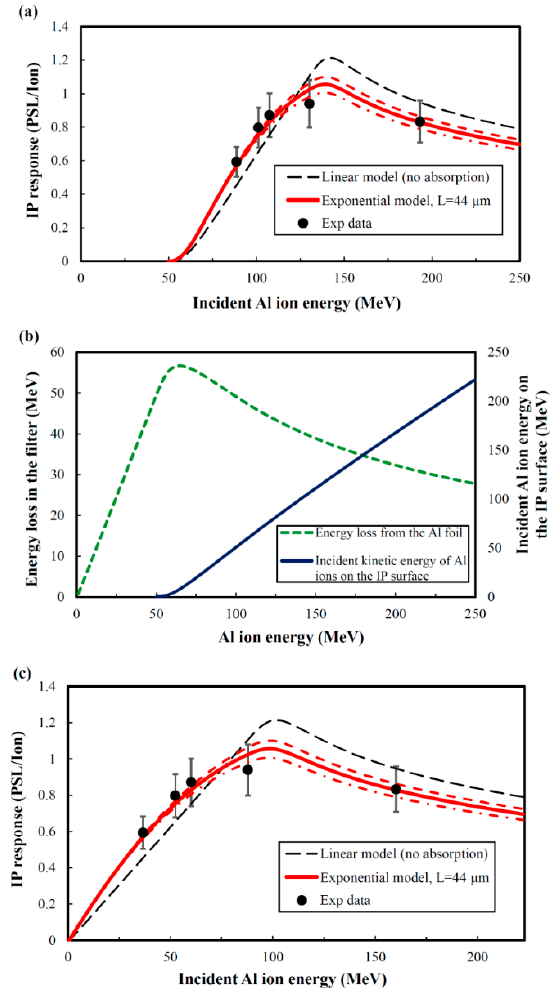
Figure 4. ( a ) IP response of BAS-TR IP is shown as a function of incoming Al ion energy before the filter. ( b ) Energy loss in the filter is shown as a function of Al ion energy (dashed green line). The incident kinetic energy of Al ions on the phosphor layer after penetrating through the filter is also shown as a function of Al ion energy (solid blue line). ( c ) IP response of BAS-TR IP is shown as a function of the incident Al ion energy on the phosphor layer.